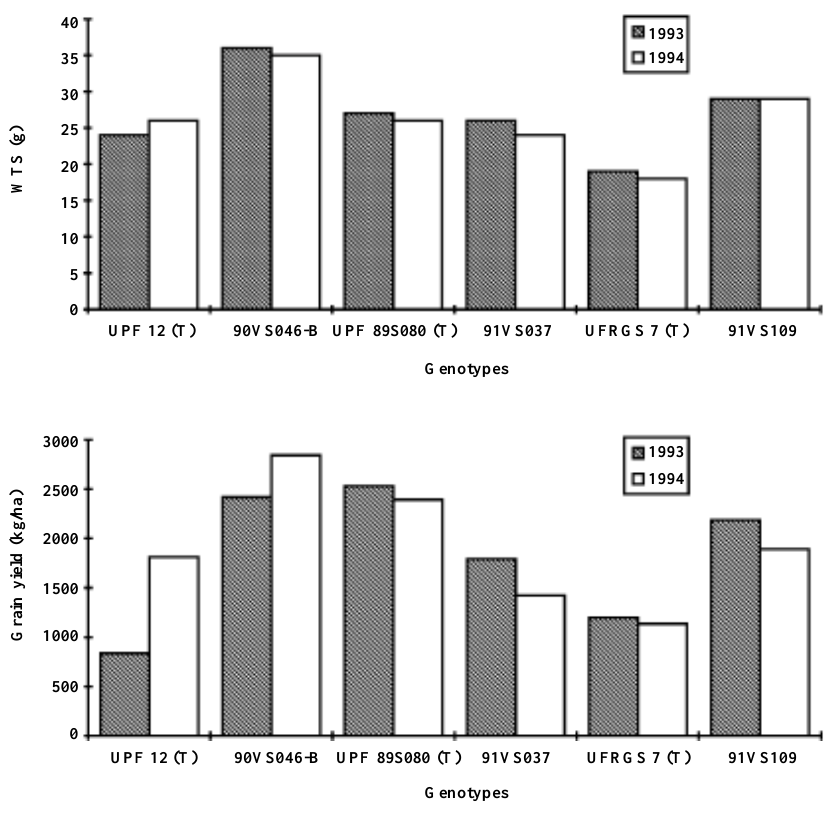
Figure 6 - Observed characteristics (weight of a thousand seeds (WTS) and grain yield) for somaclones derived from cultivars UPF 12, UPF 89S080 and UFRGS 7. Eldorado do Sul, RS,